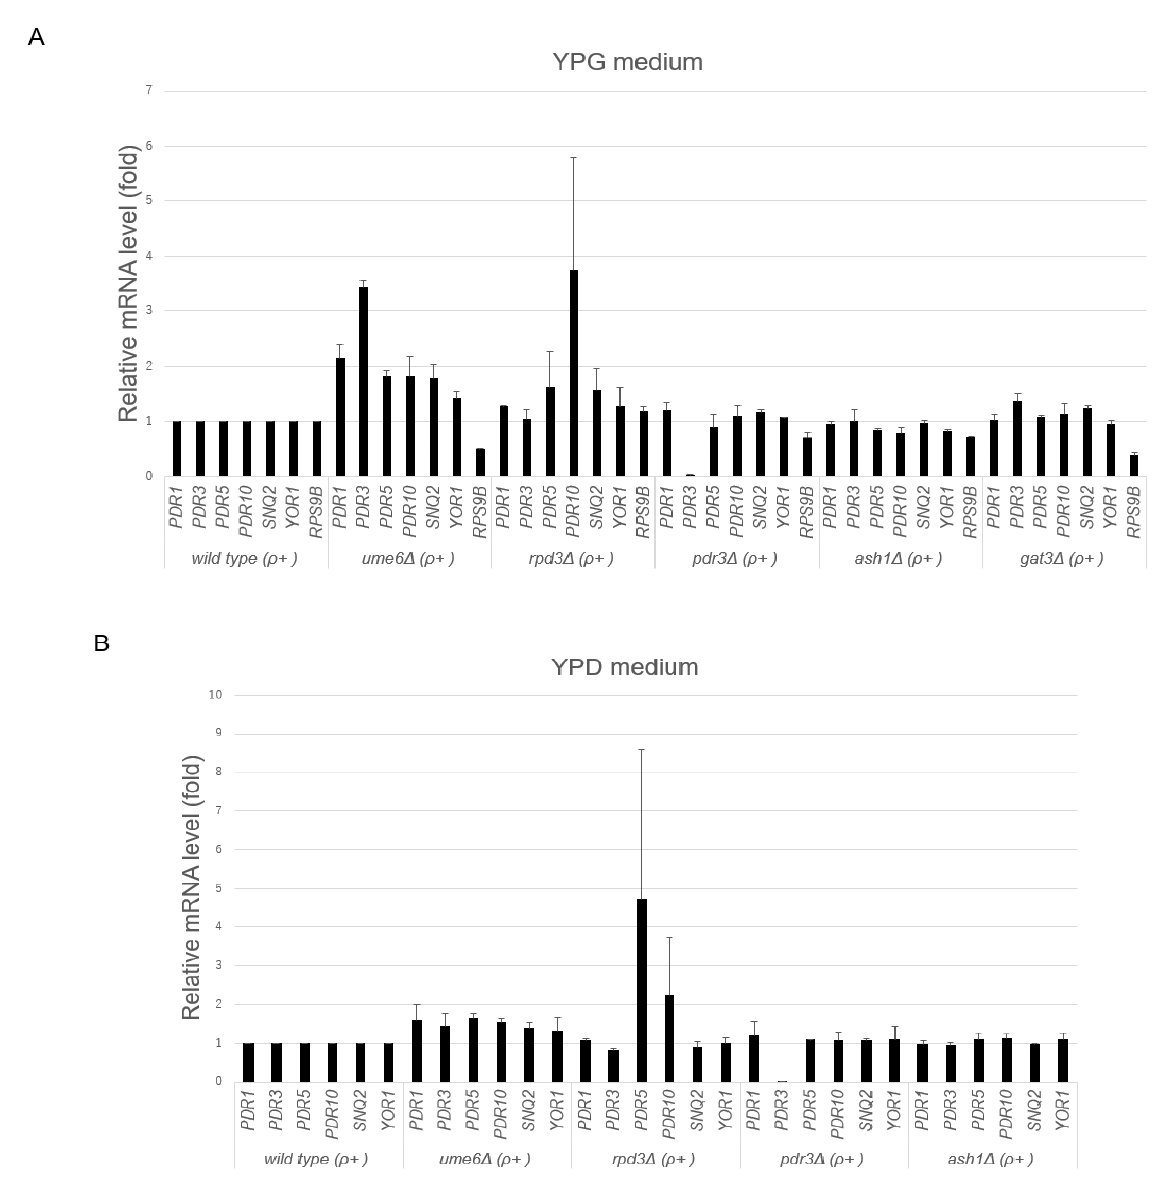
Figure 3. Transcription levels of ABC transporters and their regulators in ρ + cells of the wild-type and mutant strains in the logarithmic growth phase. ( A ) ρ + cells of the wild-type, ume6 ∆ , rpd3 ∆ , pdr3 ∆ , ash1 ∆ , and gat3 ∆ strains were grown to the log phase in YPG medium. Relative PDR1, PDR3, PDR5, PDR10, SNQ2, YOR1, and RPS9B mRNA levels were determined by qRT-PCR. ( B ) Relative PDR1, PDR3, PDR5, PDR10, SNQ2, and YOR1 mRNA levels in ρ + cells of the wild-type, ume6 ∆ , rpd3 ∆ , pdr3 ∆ , and ash1 ∆ strains grown to the log phase in YPD medium were determined by qRT-PCR.